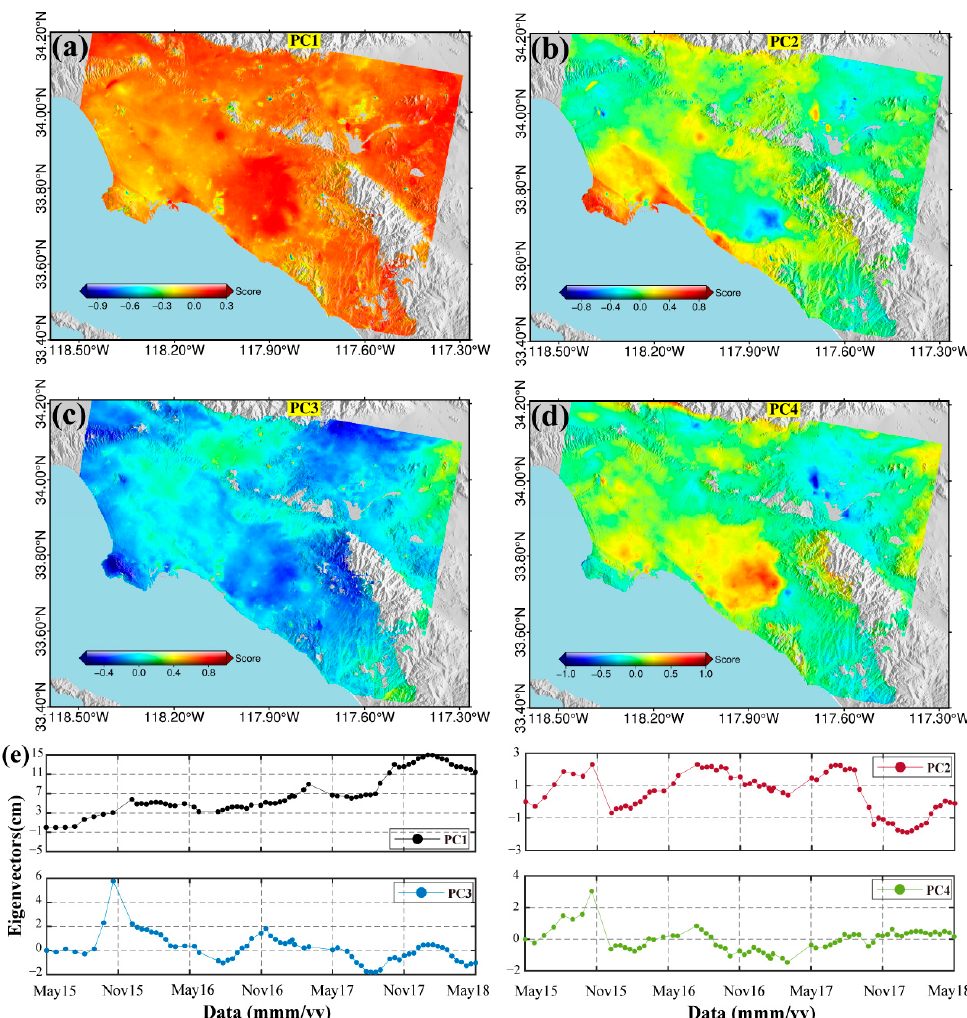
Figure 11. PCA results for the descending InSAR time series. Four independent components are isolated. ( a – d ) show the score values of the spatial patterns of the principal components, respectively, and ( e ) shows the temporal eigenvectors of each principal component.